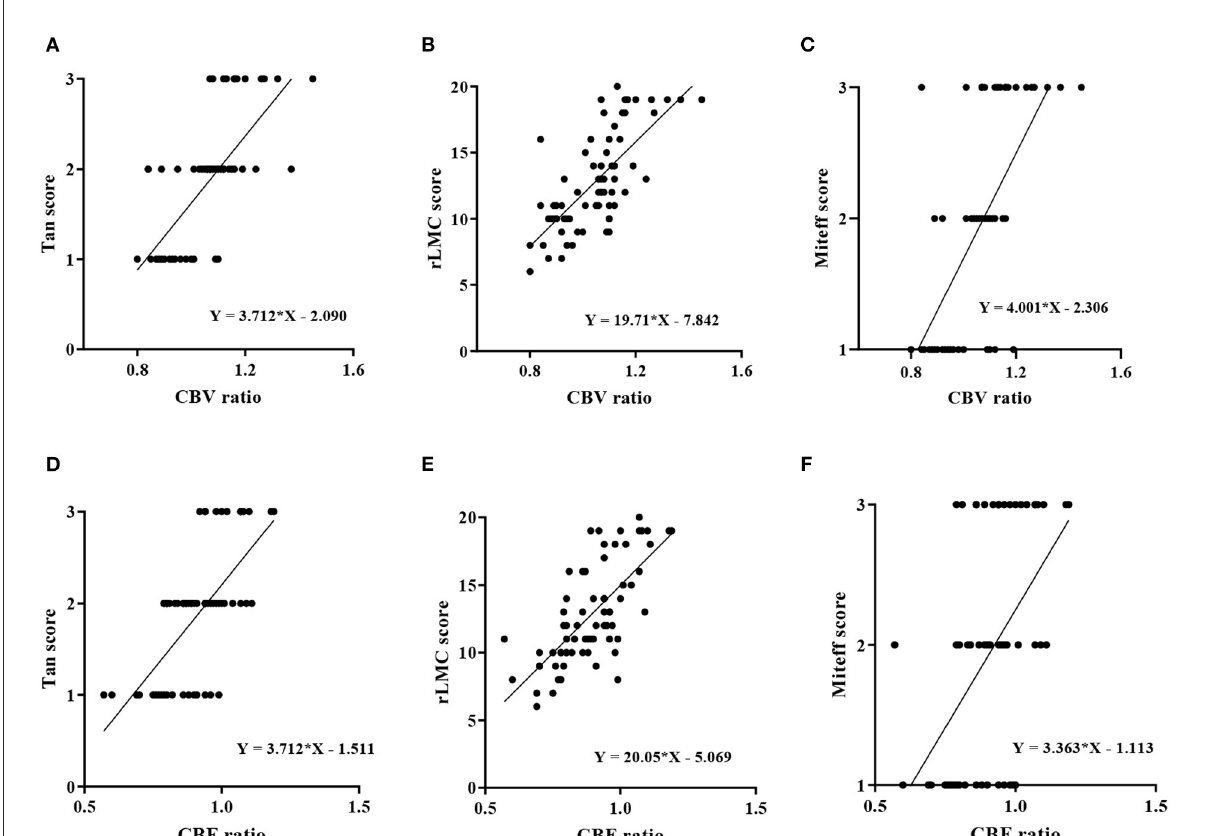
FIGURE3 Correlation analysis of perfusion parameters and the three qualitative assessments of CS. (A) rCBV was strongly positively correlated with the Tan score (r s = 0.702, P < 0.0001). (B) There was a strong positive correlation between the rCBV and rLMC score (r s = 0.705, P < 0.0001). (C) The rCBV and Miteff score were strongly positively correlated (r s = 0.625, P < 0.0001). ( D) The rCBF and Tan score were strongly positively correlated (r s = 0.671, P < 0.0001). (E) There was a strong positive correlation between the rCBF and rLMC score (r s = 0.715, P < 0.0001). (F) The rCBF and Miteff score were moderately positively correlated (r s = 0.535, P < 0.0001).